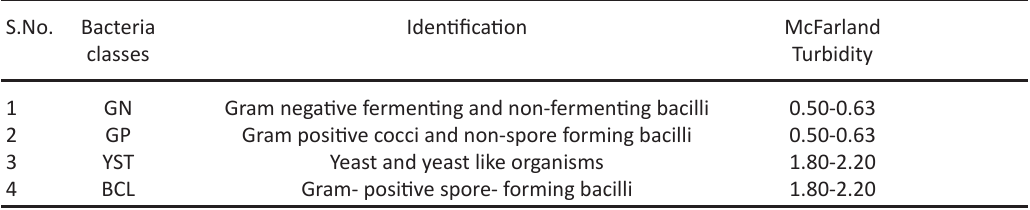
Table 1. The bacterial class identification and suspension turbidity used for card inoculation S.No.